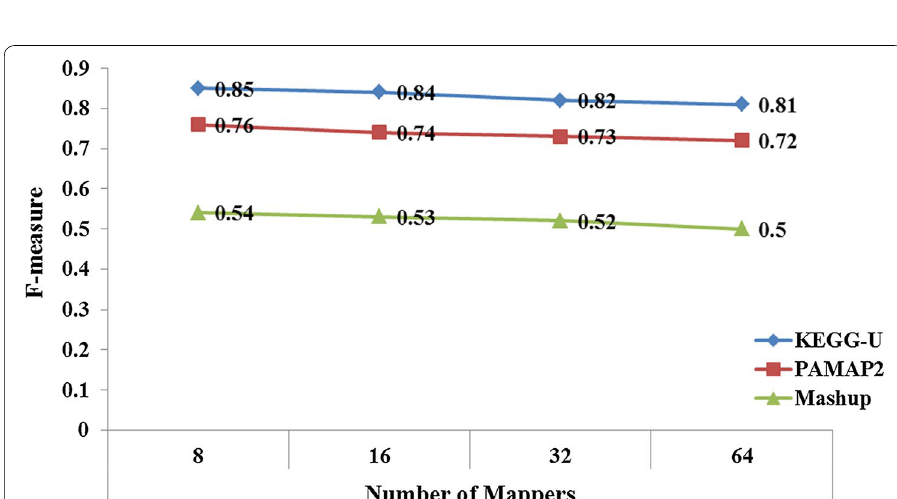
Fig. 11 F-measure values of KEGG-U, PAMAP2 and Mashup for a distinct number of mappers using UCP-